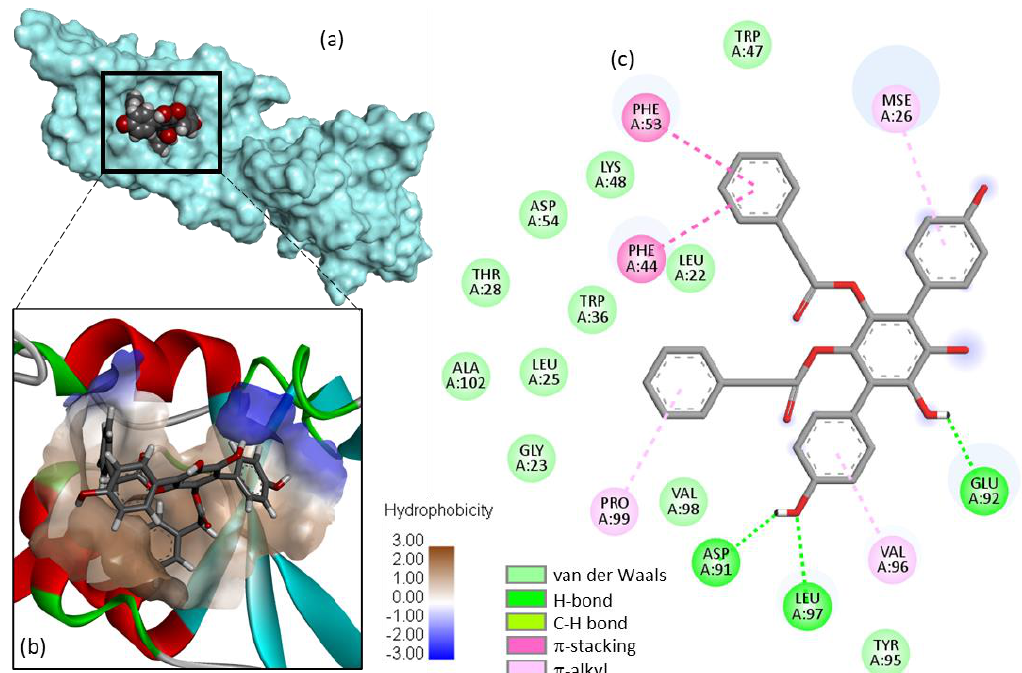
Figure 2. Molecular model of vialinin A (Vi-A) bound to USP4. ( a ) Surface model of Vi-A bound to the V98 site. ( b ) A close-up view of the compound in the binding site, with the hydrophobic/hydrophilic zones colored in brown and blue, respectively. ( c ) Binding map contact, with the indicated color code.